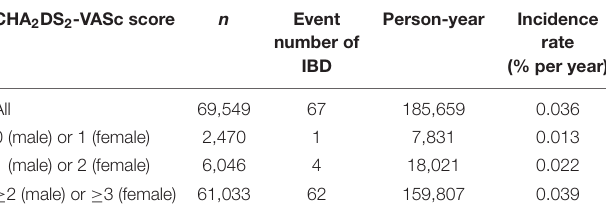
TABLE 2 | Incidence of IBD in relation to the CHA 2 DS 2 -VASc